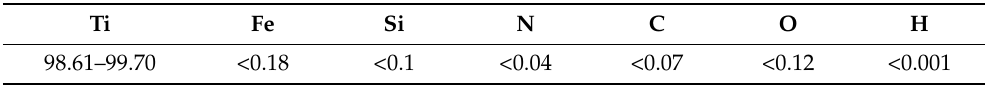
Table 1. Chemical composition of technical titanium BT1-0 (weight